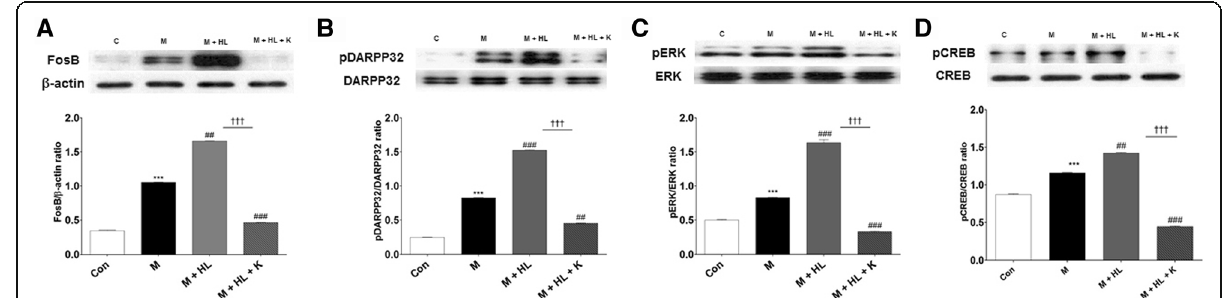
Fig. 10 Effects of combination treatment on protein expression in the striatum. Representative Western blot images (upper panel) and quantifications (lower panel) of four proteins showing significant differences between groups. Protein analyses of FosB ( a ), pDARRPP32 ( b ), pERK ( c ) and pCREB ( d ). Western blot analyses showing significantly lower expression levels of FosB, pDARRPP32, pERK, and pCREB after combination treatment. C: -dopa (20 mg/kg). * p < 0.05 vs. control group, ### p < 0.001 and ## p < 0.01 vs. MPTP group, and ††† control, M: MPTP, K: KD5040, HL: high dose of L p < 0.001 vs. each dose of